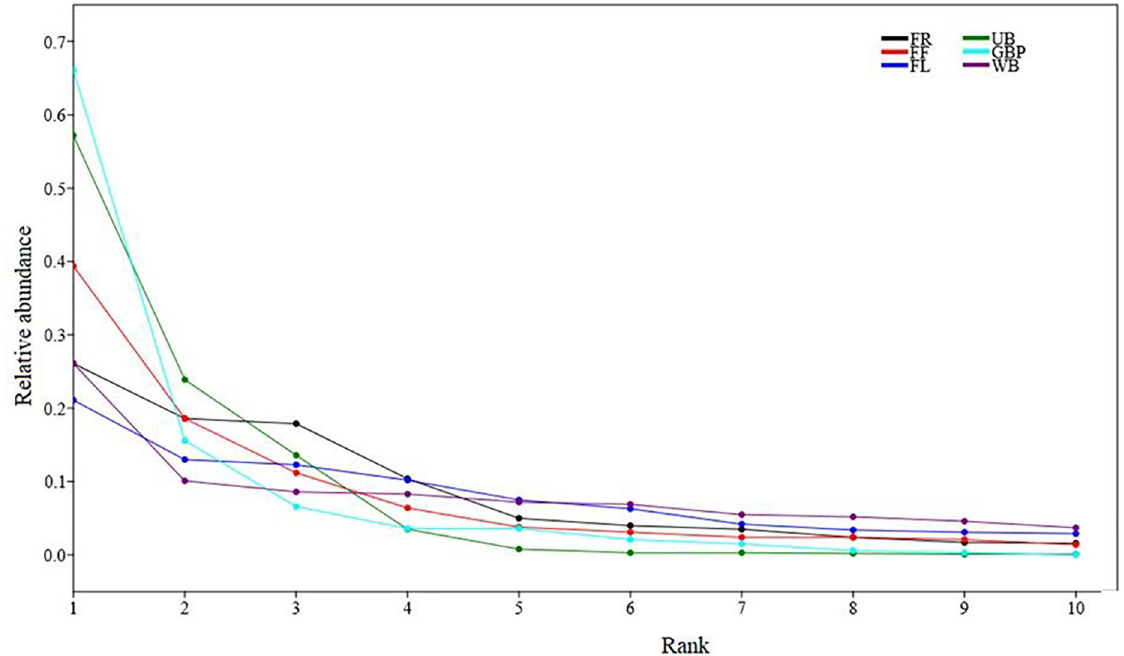
Fig 4. Rank abundance (Whittaker curves) of top ten diurnal raptors. Coloured lines represent rank abundance diversity curves for six habitat types.